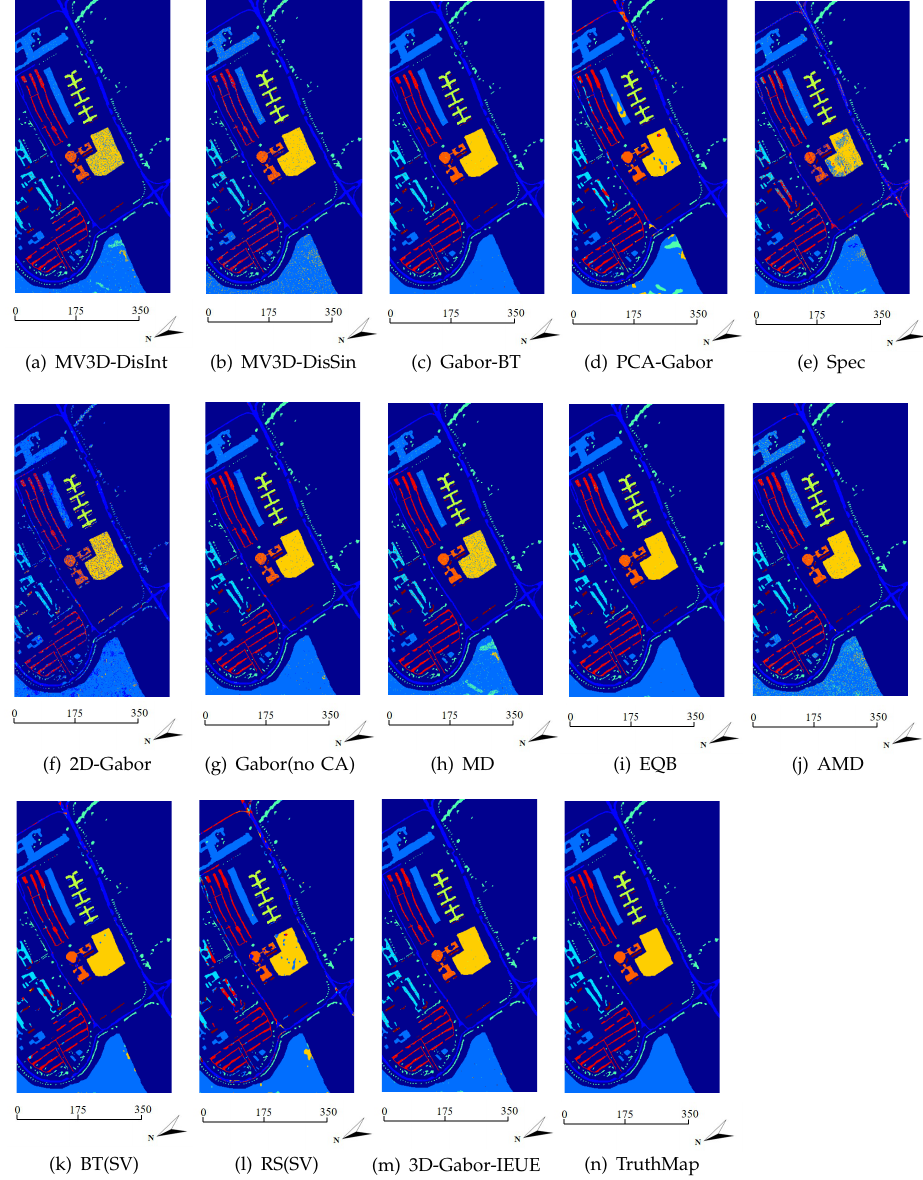
Figure 9. Classification maps of the University of Pavia data with a final of 285 training samples.